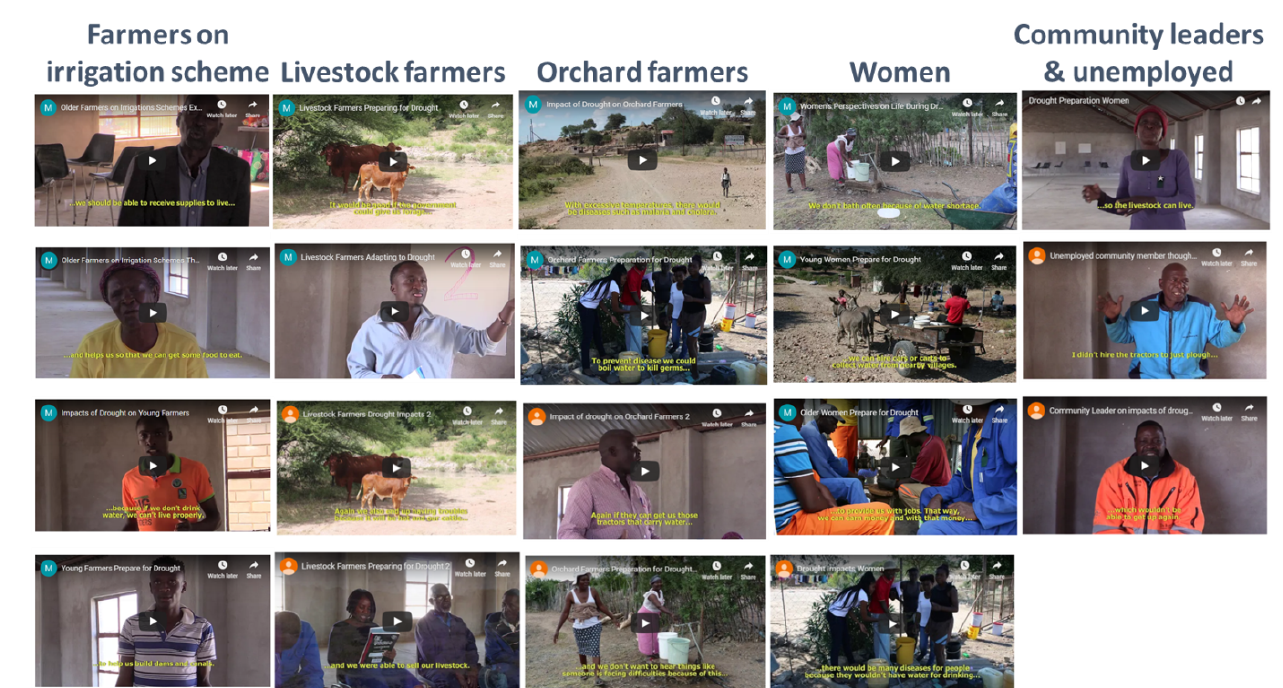
Figure 6. Recorded and edited future drought narratives developed in community workshops in the CreativeDrought project (see https: //creativedrought.wordpress.com/videos/, last access: 17 December